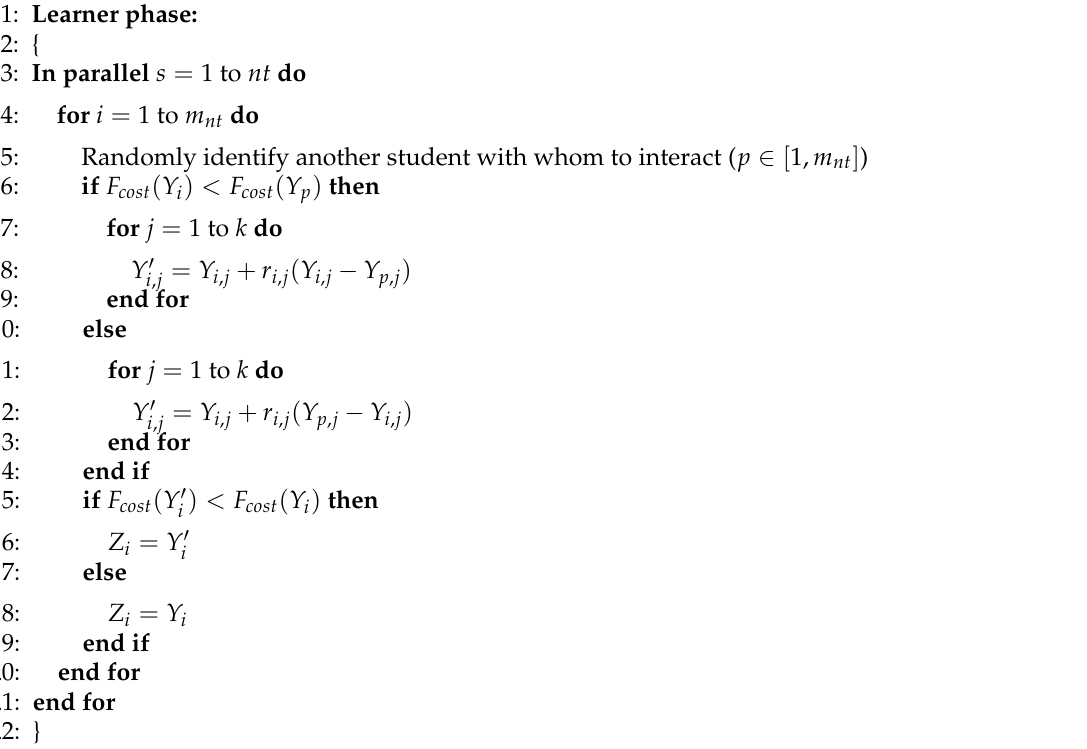
Algorithm 8 Learner phase of SPP_TLBO algorithm.